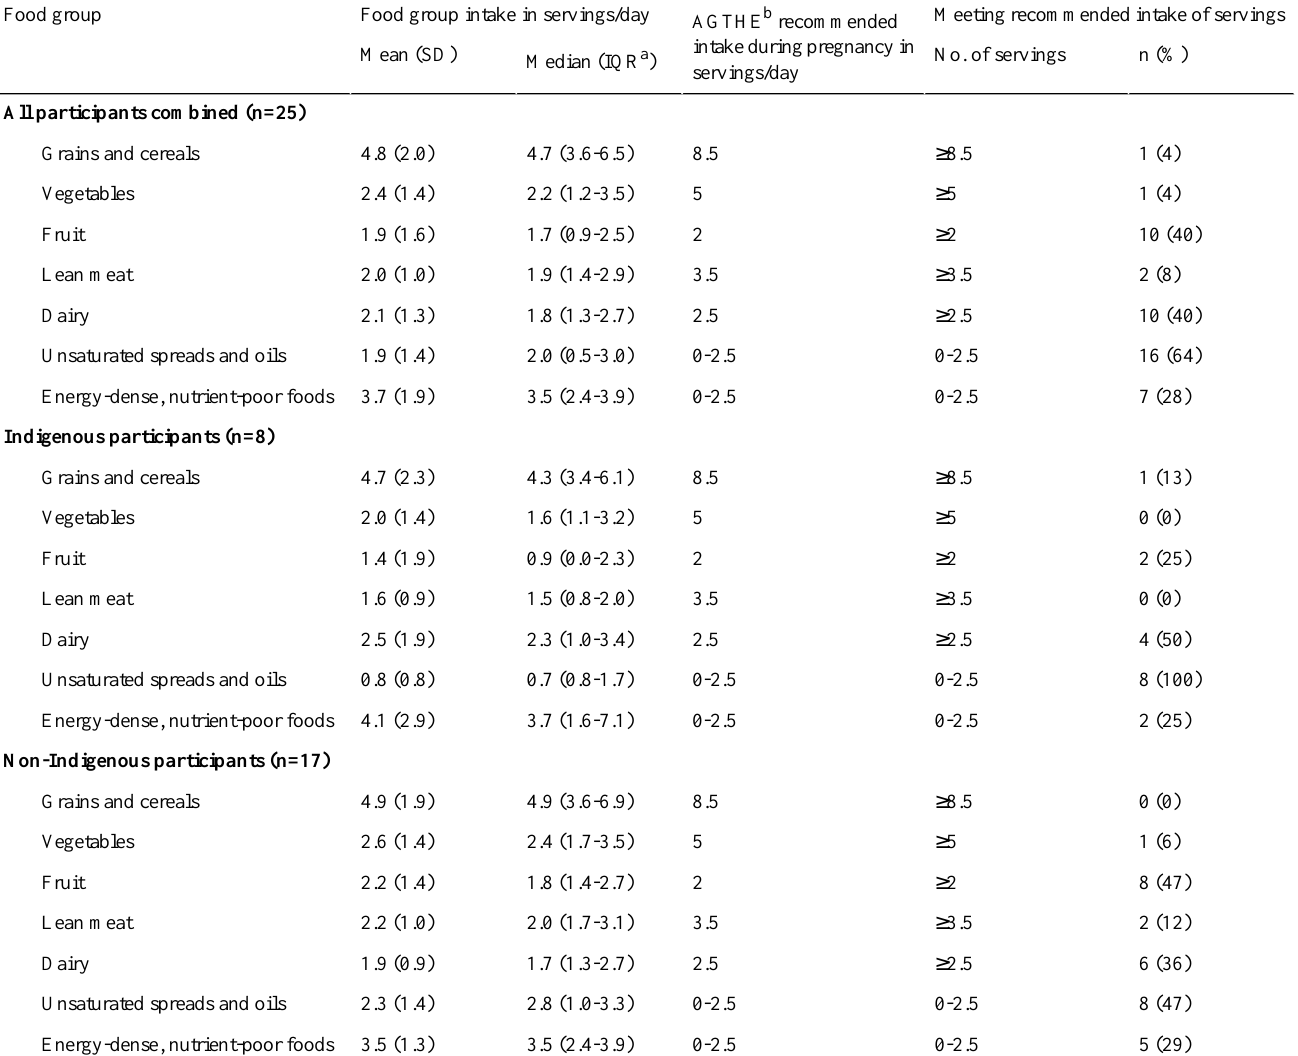
Table 1. Intake of core foods as assessed by the Selected Nutrient and Diet Quality (SNaQ) brief analysis tool from the Diet Bytes and Baby Bumps image-based dietary records (n=25).